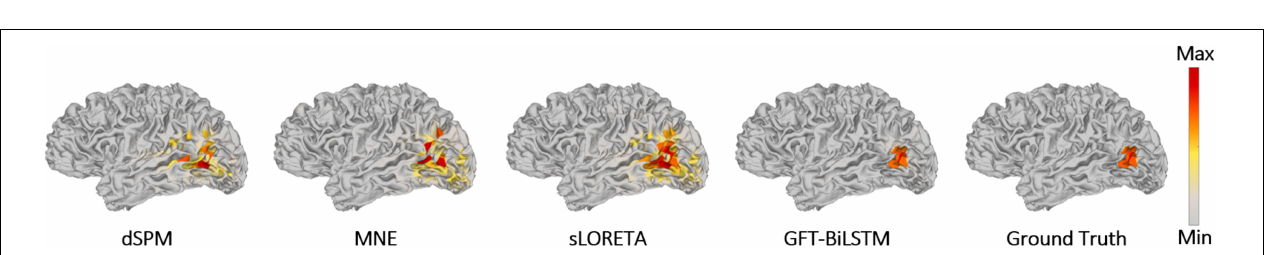
FIGURE 5 | The performance comparison of different ESI inverse solutions with a single activated area. (A) The comparison of AUC at different SNR levels. (B) The comparison of LE at different SNR levels.